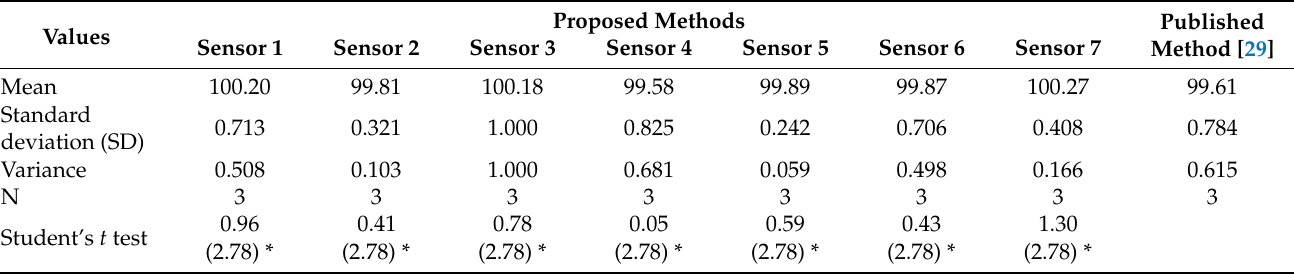
Table 5. Statistical comparison between the determination of gemifloxacin in pure form by the proposed potentiometric methods and the published